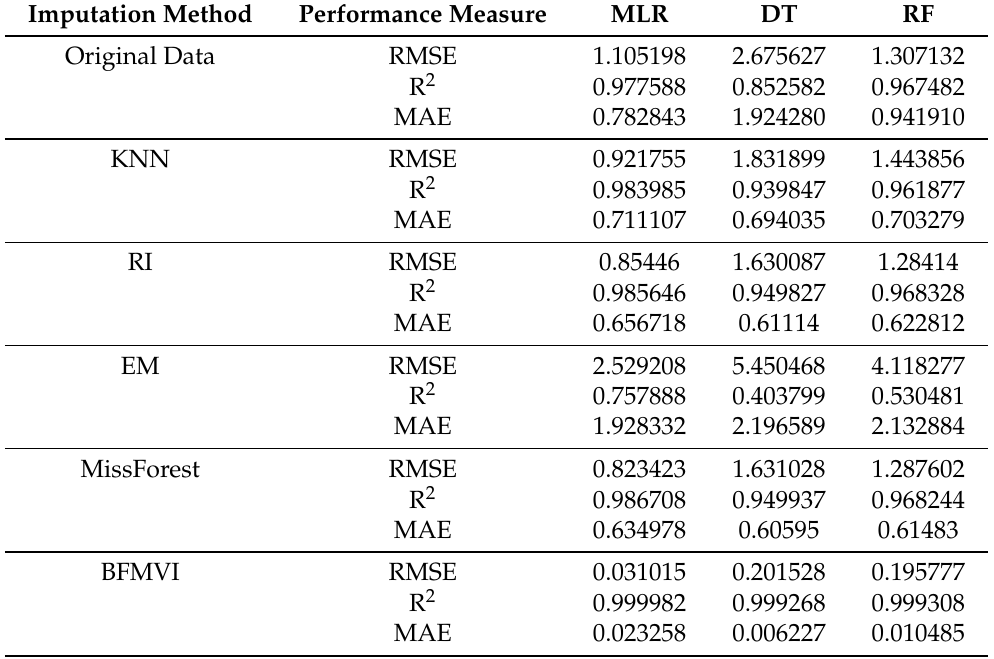
Table 3. Comparison of Imputation Techniques on C 6 H 6 Sensor